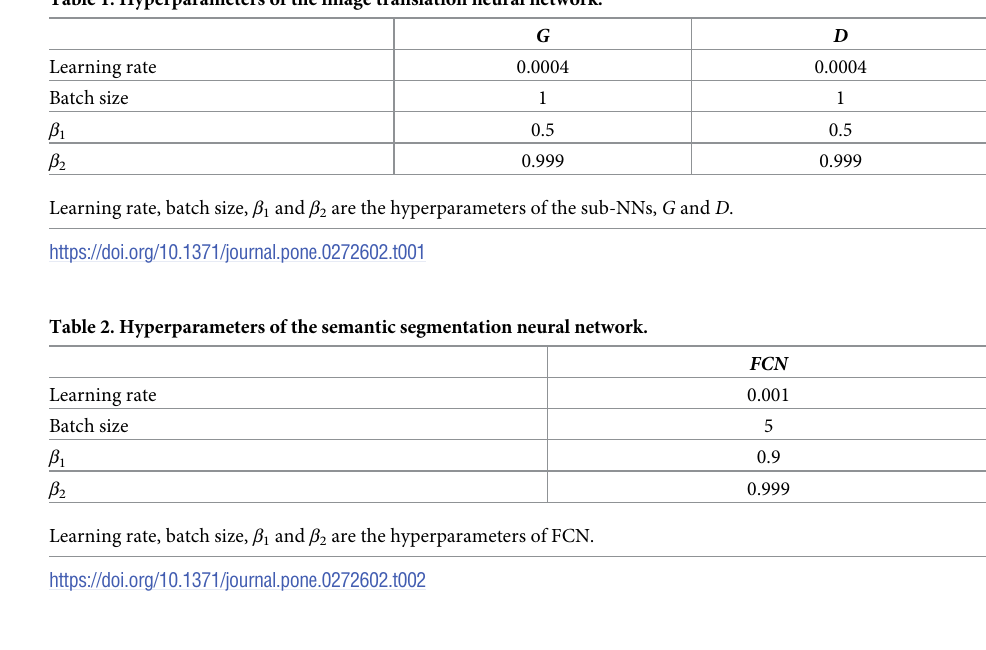
optimizer for 200 epochs, and the hyperparameters were shown in Table 2.